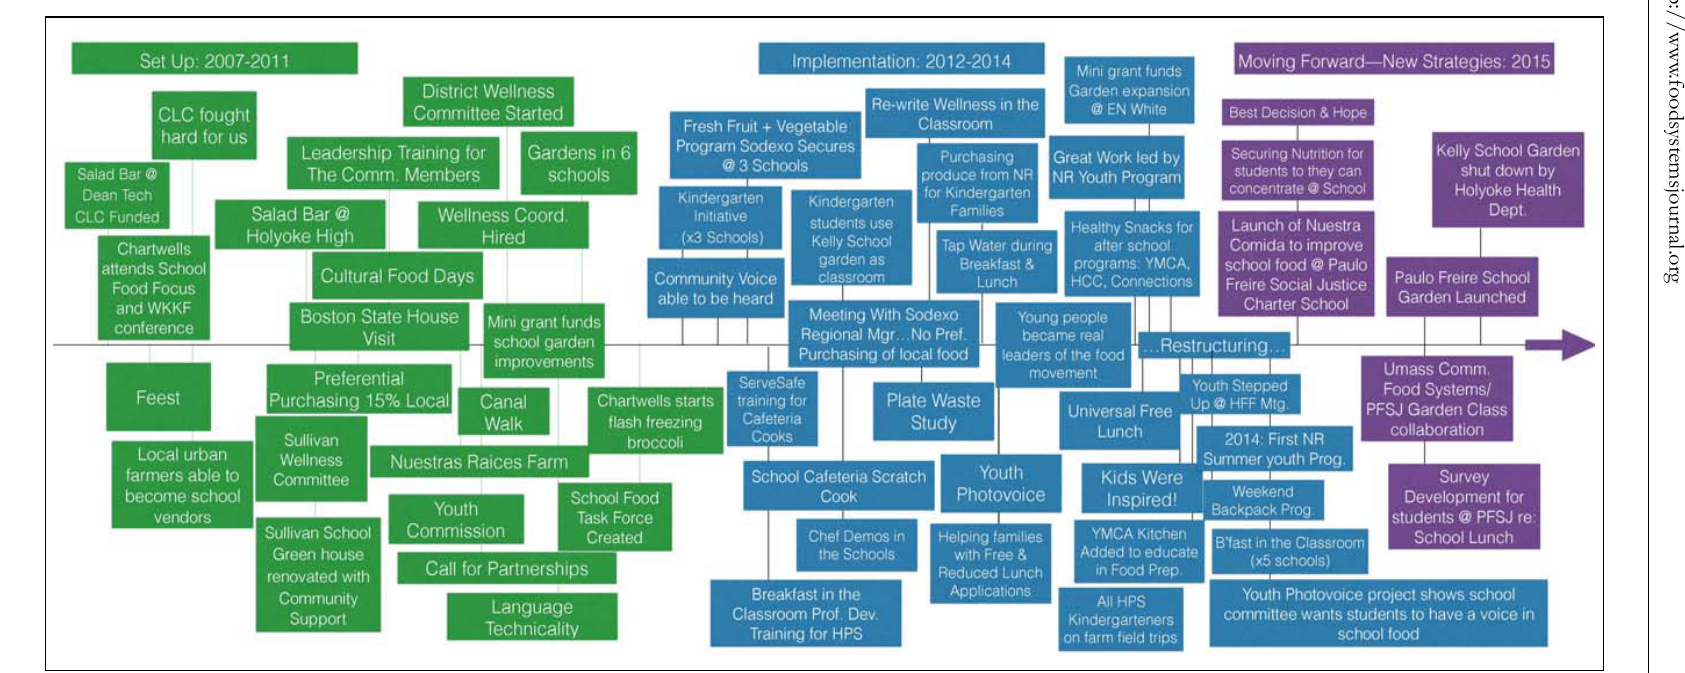
Figure 1. HFFPC Timeline Asset